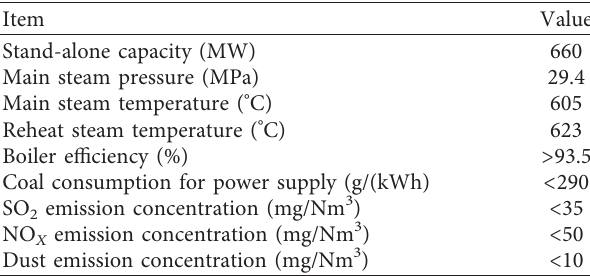
Table 1: CFB boiler design indicators and parameters.